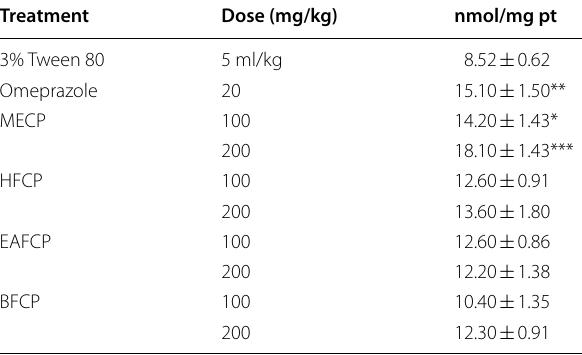
Values are expressed as mean